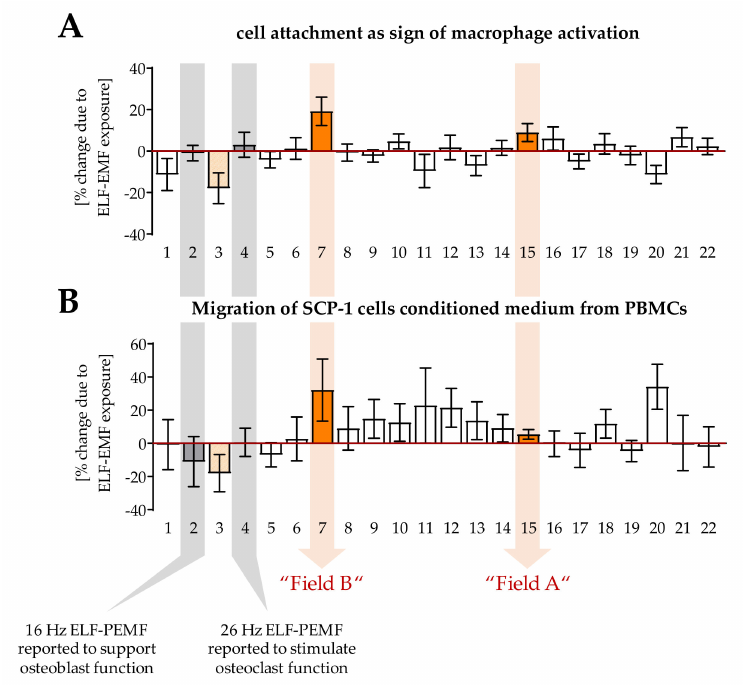
Figure 1. Screening of 22 different ELF-PEMF on macrophage function. Freshly isolated PBMCs (N = 7) were stimulated with 200 nM PMA and exposed to the different ELF-PEMFs for 7 min each in a blinded manner. ( A ) After 24 h, cell attachment was determined by Hoechst 33342 staining, and ( B ) conditioned medium was collected and added (1:1) to SCP-1 cells in a migration assay. The ELF-PEMF effects are displayed as fold of control (without ELF-PEMF exposure). After unblinding, field #2 was identified as the ELF-PEMF, which showed positive effects on osteoblast function in earlier studies [15,25,29] and field #4 was identified as the ELF-PEMF, which additionally stimulated osteoclast function in earlier studies [16]. Fields #3, #7, #15, and #20 were further investigated, of which #7 and #15 showed diverse effects on macrophage function—termed field A and field B in the following